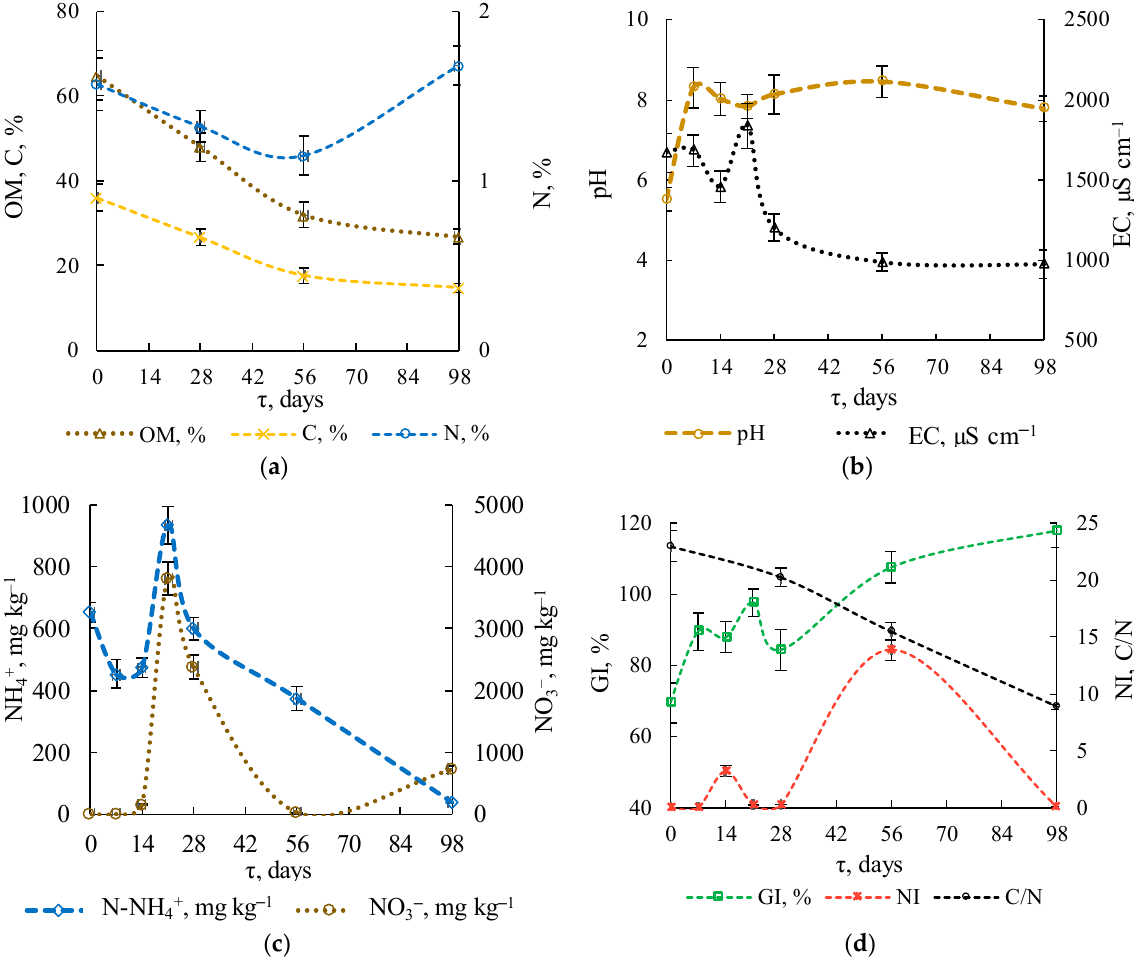
Figure 2. Changes in chemical and physical parameters and stability indicators: ( a ) relative OM, C, N content; ( b ) pH and EC; ( c ) NH 4+ and NO 3– content; ( d ) stability indicators: GI, NI, C/N.